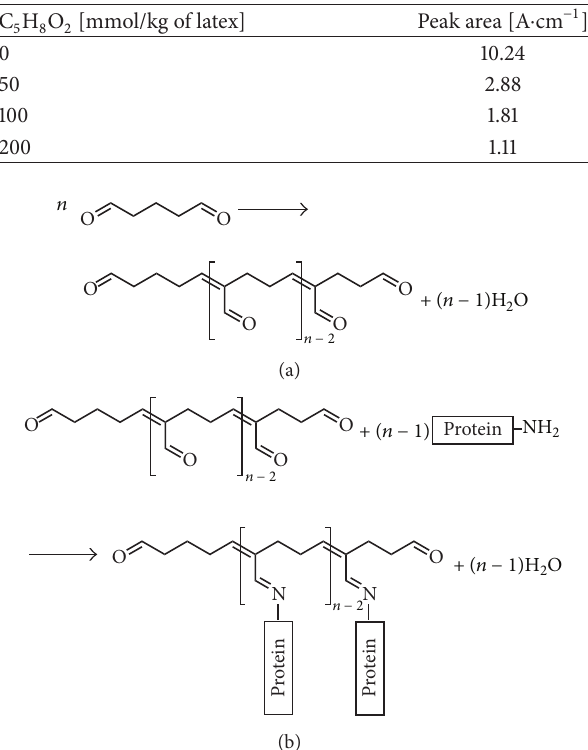
Table 1: Peak area of amide II band at wavenumber 1,561 cm −1 in ATR-IR spectra of NR films obtained from untreated and treated fresh NR latex.